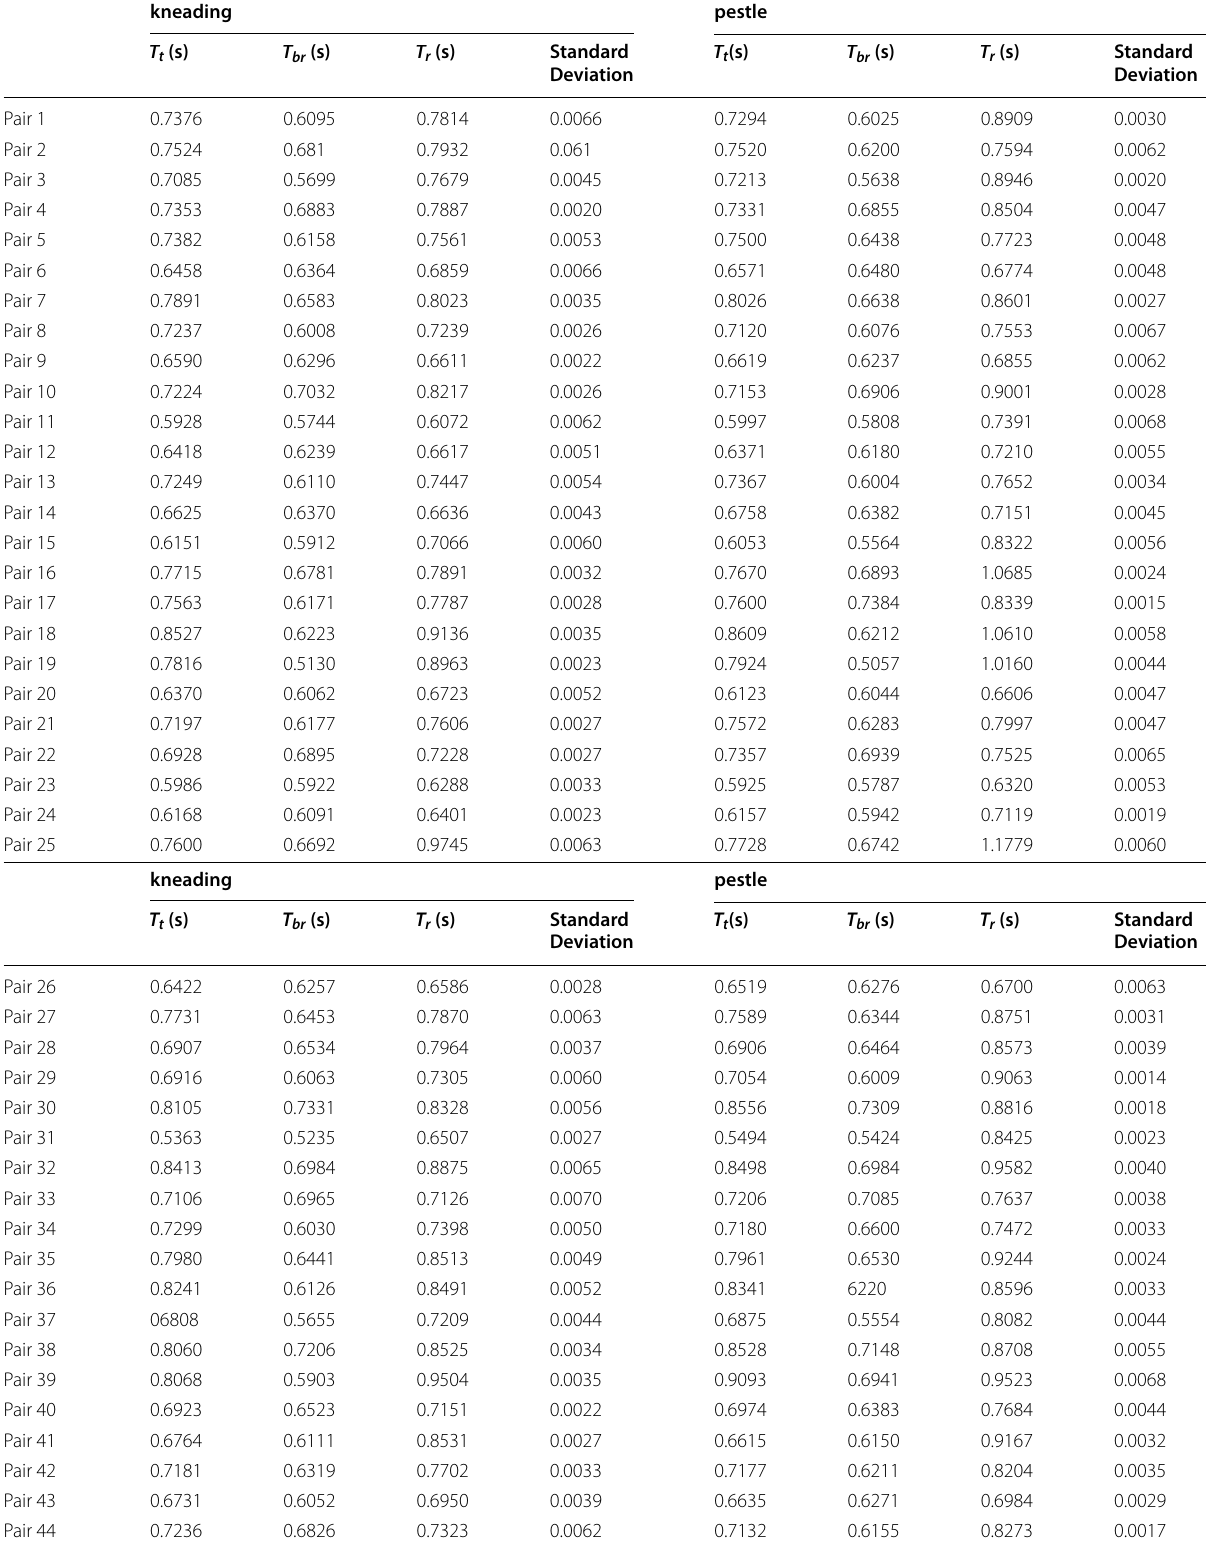
Table 3 Average measured T t , T br and T r cycles in all implicit collaboration pairs for both the pestle and the kneading kneading pestle T t (s) T r (s) Standard T r (s) Standard Deviation